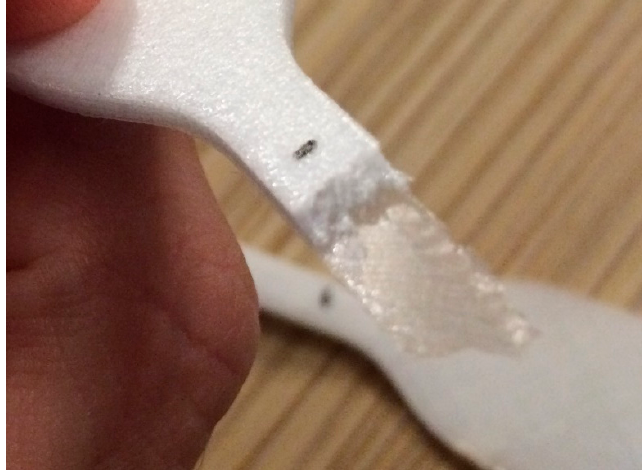
Figure 2. Specimen after test.